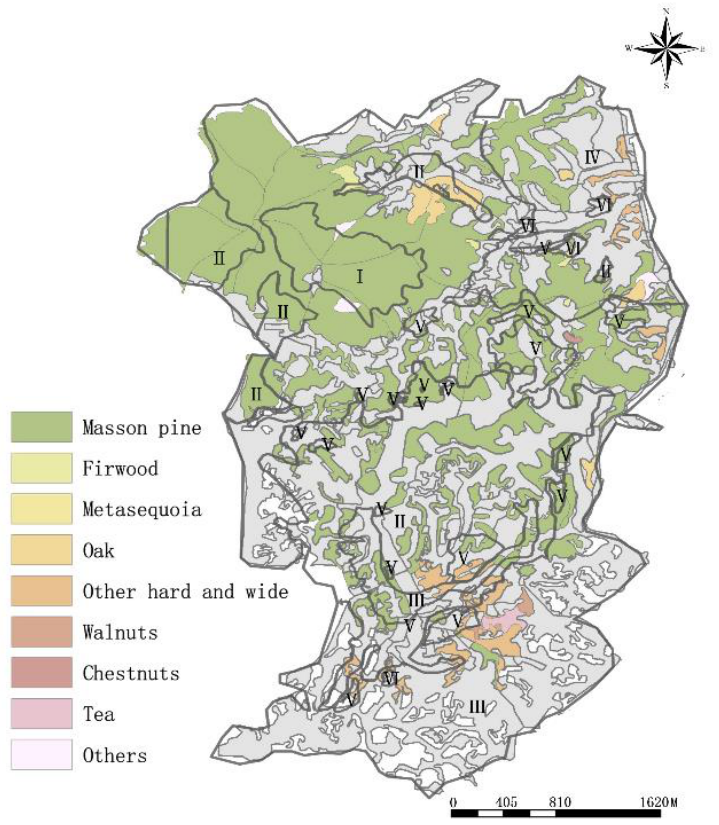
Figure 2. Spatial distribution of dominant species in South Lake Scenic Area. Note: I is a special protection zone, II is a scenic tour area, III is a scenic restoration area, IV is a scenic coordination area, V is a tourism service area, and VI is a development control area. Table 2. List of dominant species in South Lake Scenic Area.